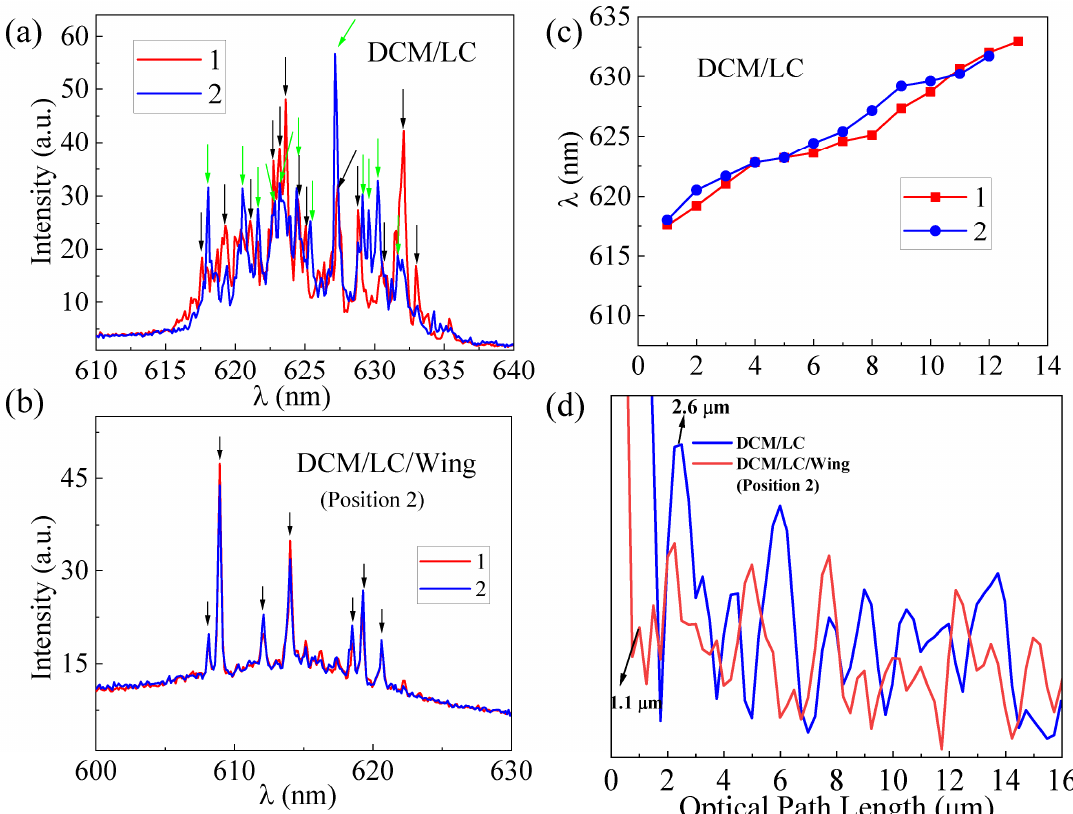
Figure 7. ( a ) Single shot spectra of DCM/LC at the pumping energy of 309 µ J, green and black arrows: the peak positions of the two single shot spectra; ( b ) Single shot spectra of DCM/LC/Wing at Position 2 with the pumping energy of 260 µ J; ( c ) The location of the spikes marked by arrows in ( a ); ( d ) Power Fourier Transform analysis for the emission spectra in the inset of Figure 3d.